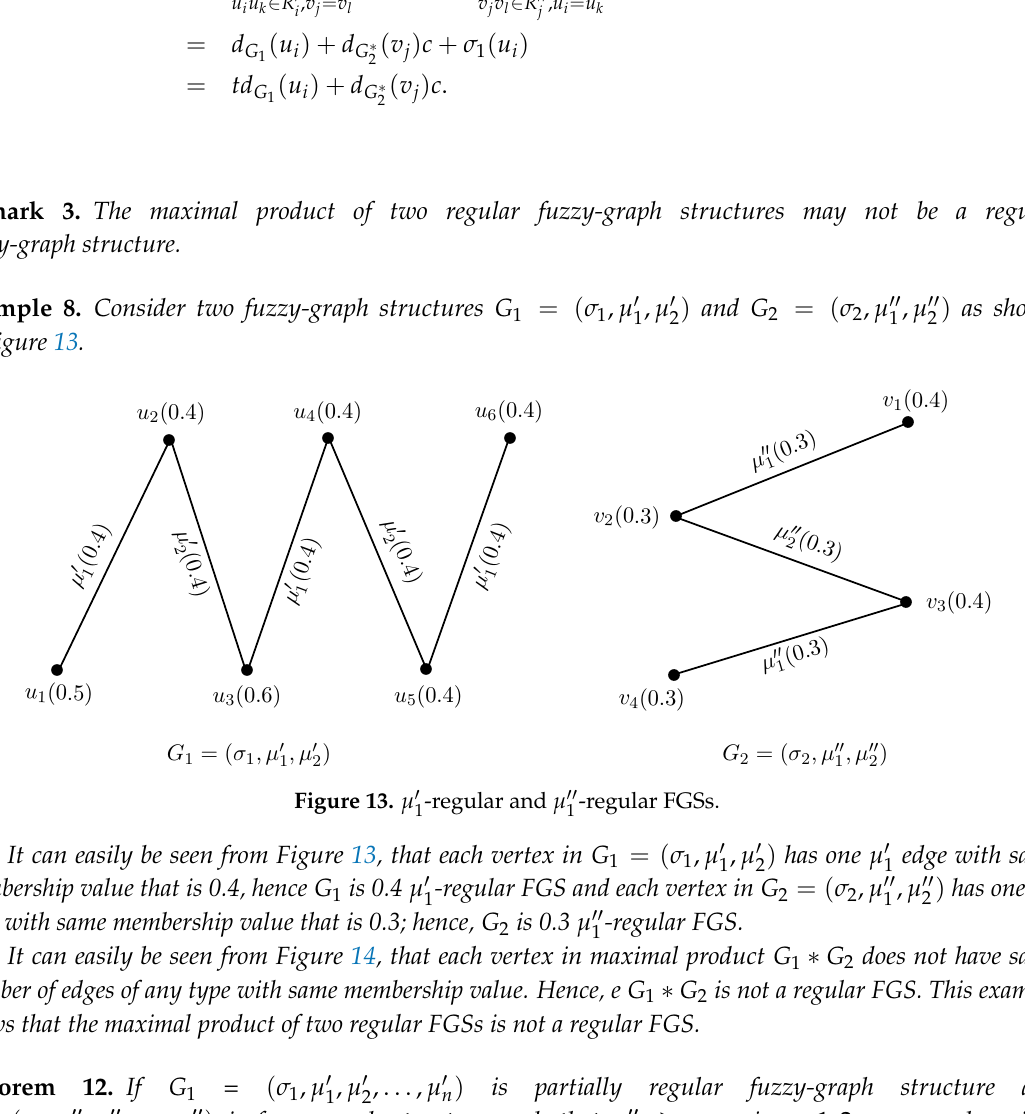
-regular 1 -regular FGSs 1